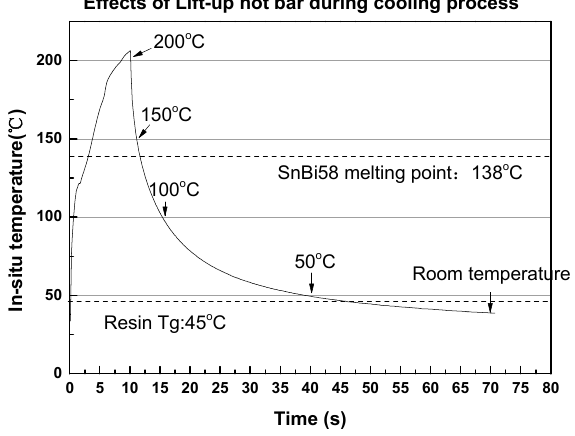
Figure 11. The in-situ temperature profile of solder ACFs joint by US bonding.